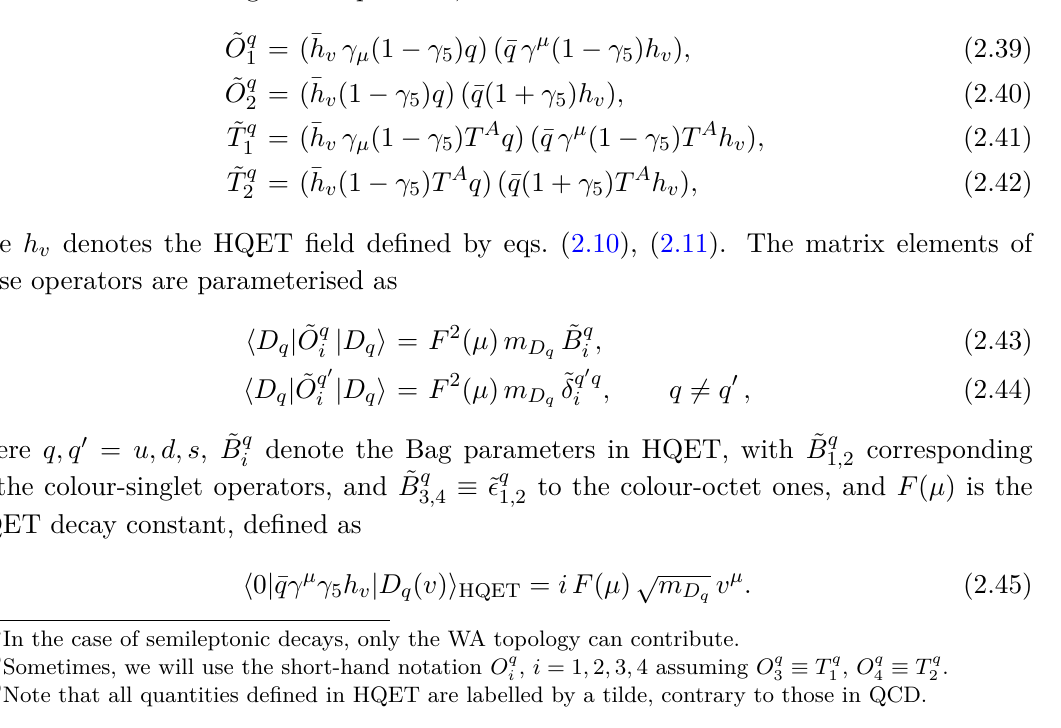
one-loop contributions, cf. ˜Γ in eq. (1.1), in which the spectator quark is directly involved. 6 These correspond respectively to the weak exchange (WE), Pauli interference (PI) and weak annihilation (WA) diagrams, depicted in figure 5. 8 Note that compared to the terms discussed above, these contributions imply a phase space enhancement factor of 16 π 2 . The corresponding ∆ C = 0 four quark operators of dimension-six are: